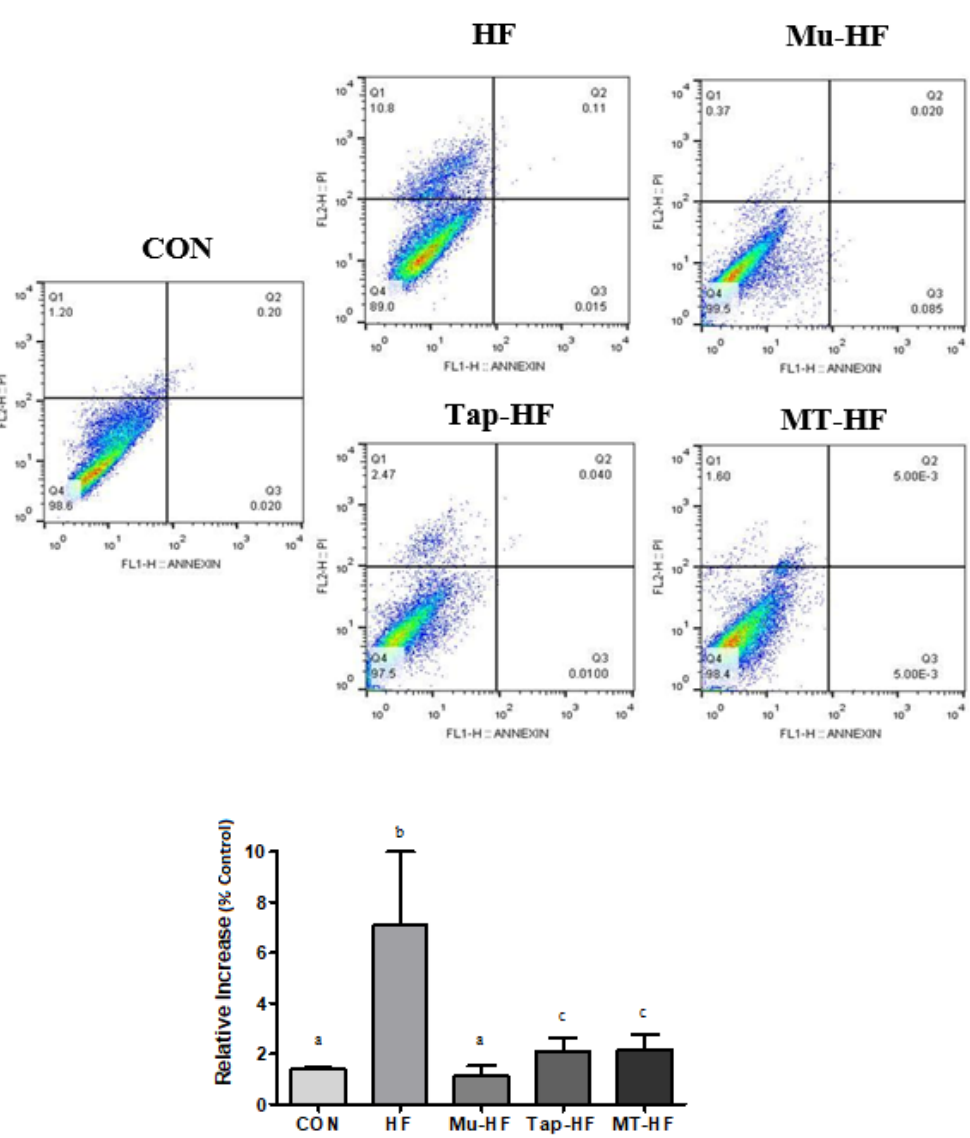
Figure 5. Monitoring of cell death in hepatic cells from rats fed a high-fat diet supplemented with murici and tapereba fruit-based beverages. ( I ) Flow cytometry analysis of hepatic cells from rats fed a high-fat diet supplemented with murici and tapereba fruit-based beverages. ( II ) Quantitative effects of murici and tapereba fruit-based beverages on cell death in hepatic cells from rats fed a high-fat diet. CON = control group; HF = high-fat group; Mu-HF = murici beverage group; Tap-HF = tapereba beverage group; MT-HF = murici and tapereba blend group. All values are expressed as mean ± SD. n = 4 to 10 per group. Means with different letters are significantly different ( p < 0.05, Tukey’s